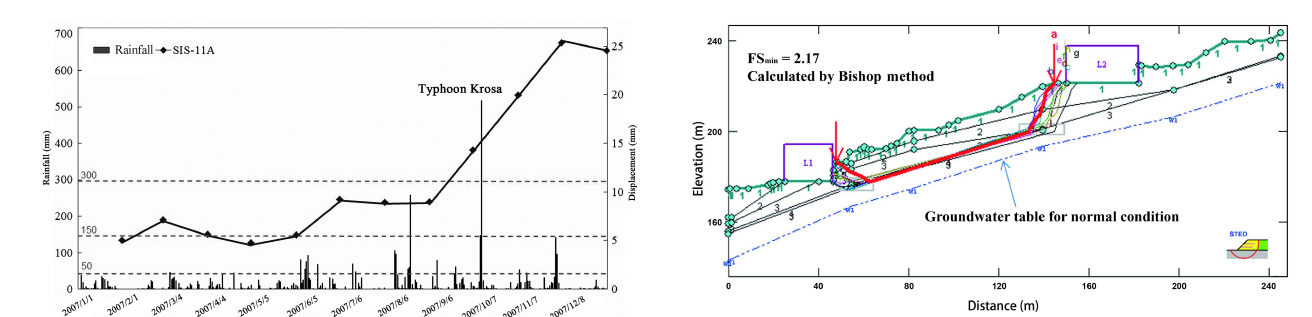
Figure 13. Relationship between displacement measured by the in- clinometer (no. SIS-11A) and daily rainfall.